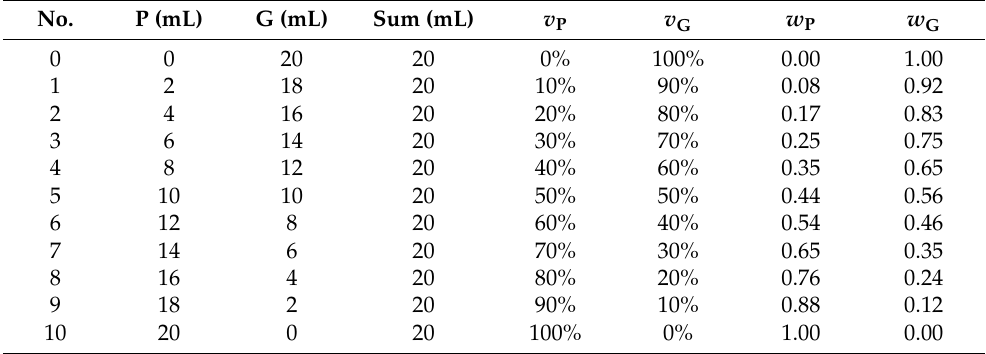
Table 1. The volume fraction v and mass fraction w of each component for standard samples of extractants containing xylene (G) and n-heptane (P) at room temperature.